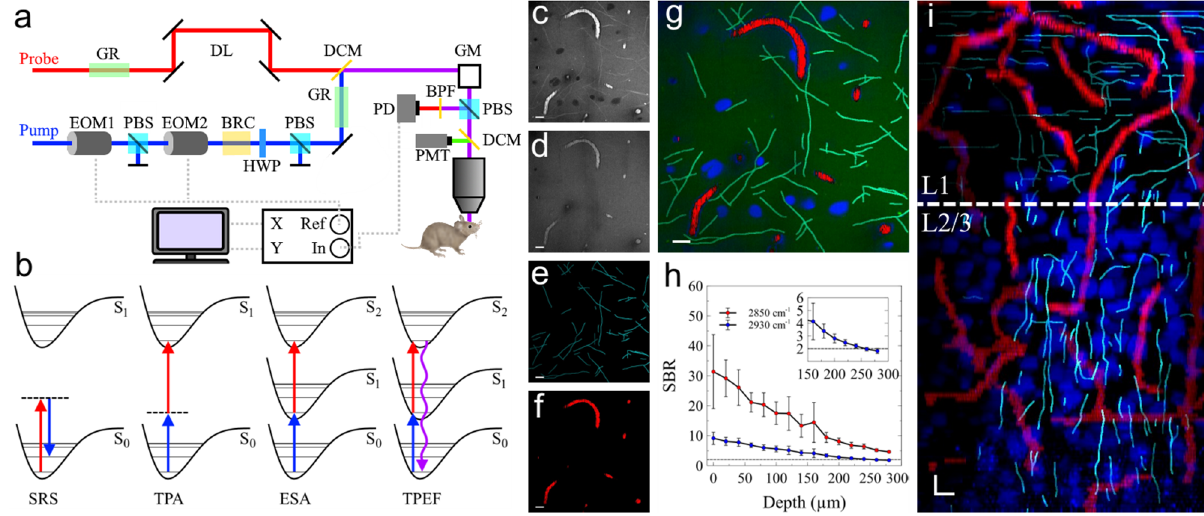
Fig. 1 Construction of the SNARF microscope and imaging of a live mouse brain. a Experimental set up. DL delay line, DCM dichroic mirror, GM galvanomirrors, EOM electro-optic modulator, PBS polarizing beam splitter, BRC birefringent crystal, HWP half-wave plate, GS grating-based pulse stretcher, PD: photodiode, PMT photomultiplier tube. b Energy level diagrams of the multiphoton techniques employed in SNARF microscopy. SRS stimulated Raman scattering, TPA two-photon absorption, ESA excited state absorption, TPEF two-photon excited fl uorescence. c , d SRS and TAM imaging at 2850 and 2930 cm − 1 , respectively. e Extracted myelin signal. f Extracted blood vessels. g Composite image of lipids (green), proteins (blue), myelin (cyan), and blood vessels (red) after signal extraction and spectral unmixing. h Signal-to-background ratio (SBR) of each wavenumber as a function of depth. Error bars represent standard deviation of all pixels in the images at each depth. i Simulated B-slice with a white dashed line at 100 µ m below pial surface. Scale bars: 10 µ